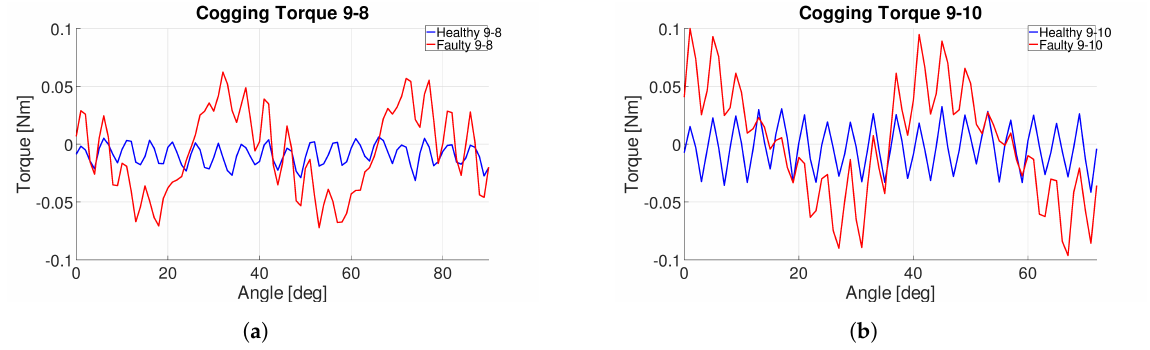
Figure 5. Cogging torque comparison over a B-EMF period of 9-8DL ( a ) and 9-10DL ( b ) with a static eccentricity of 0.2 mm.